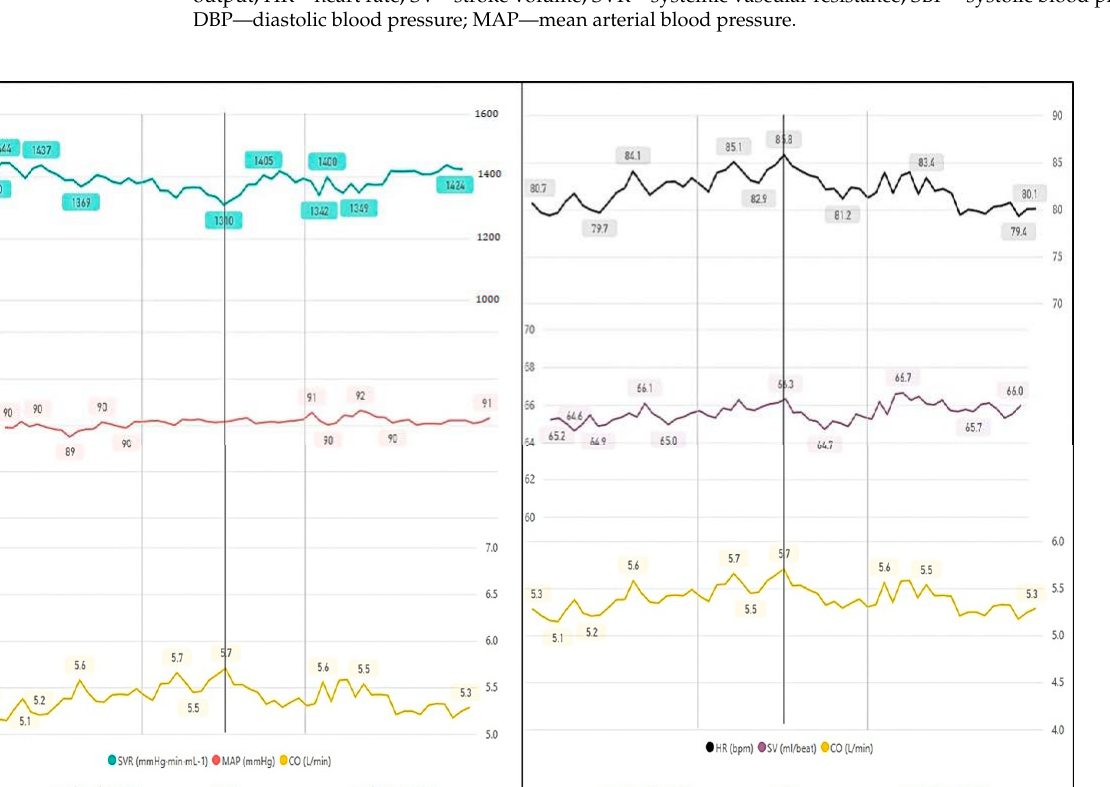
Figure 2. Continuous monitoring 30 min before and after epidural anesthesia. SVR—systemic vascular resistance;